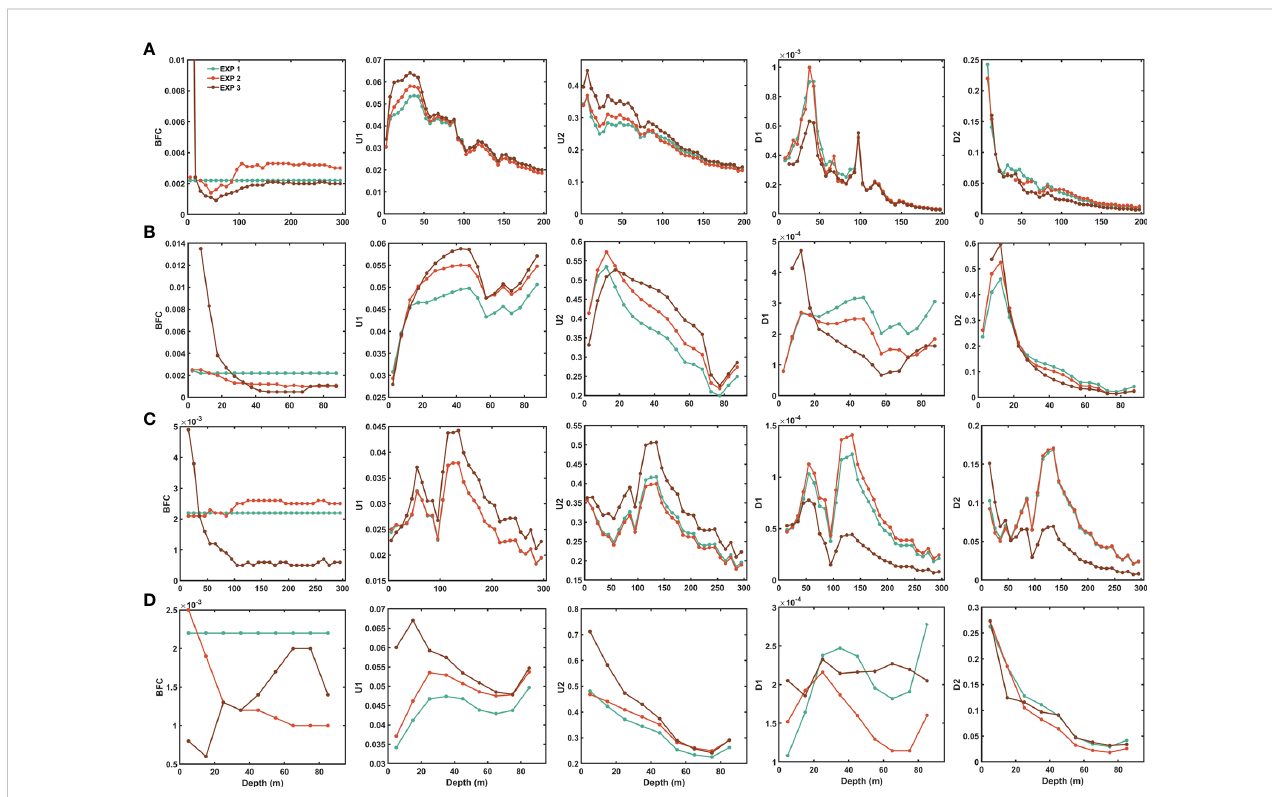
FIGURE 11 Relations of the BFCs, bottom current velocity of diurnal (U1) and semidiurnal (U2) tides, bottom friction dissipation of diurnal (D1) and semidiurnal (D2) tides versus water depth in the East China Seas (A row ) , the West Korea Bay (B row ) , the Zhejiang-Fujian provinces (C row ) , the middle South Yellow Sea (D row ) ,